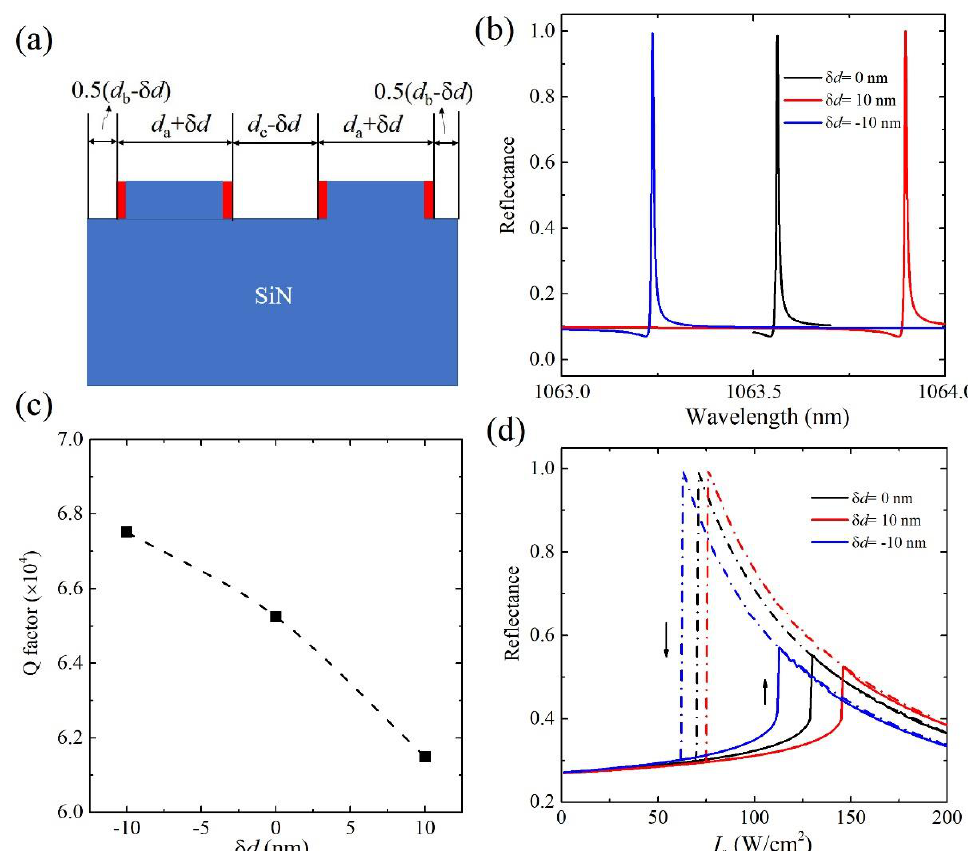
Figure 7. ( a ) Schematic of a unit cell of the GMR nanostructure if the designed width d a has an error δ d introduced during the nanofabrication. The red parts in the grating represent the error δ d. ( b ) Reflectance spectra, ( c ) Q -factor and ( d ) optical bistability in GMR nanostructures ( δ = 0.1) of δ d = ± 10 nm at θ = 1°.